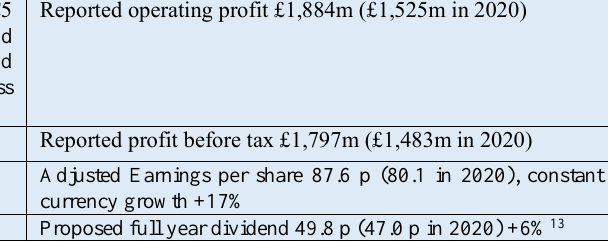
Table 2 (cont.). Financial Performance of Representative Agents of the Publishing Academic Business Increased investment for Springer Nature with an additional €5 million US$4.9 million) invested in staff training and development, along with an expanded diversity, equality, and inclusion programs, data collection for better progress monitoring, and new employee networks. 12